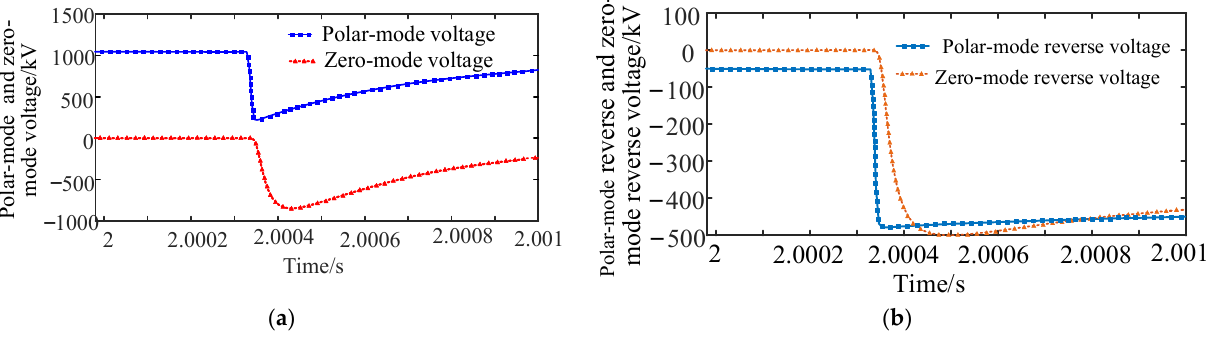
Figure 9. Positive metal grounding short ‐ circuit fault result: ( a ) polar ‐ mode and zero ‐ mode voltage waveforms. ( b ) Traveling wave waveforms of polar ‐ mode reverse ‐ voltage and zero ‐ mode reverse ‐ age waveforms. ( b ) Traveling wave waveforms of polar-mode reverse-voltage and zero-mode voltage. reverse-voltage.